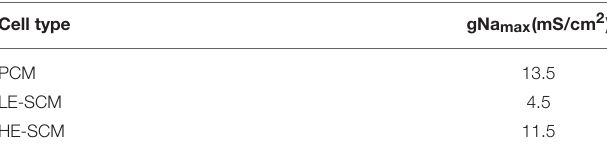
TABLE 1 | gNa max of PCMs and the two types of SCMs with LE and HE used in the computer model. Cell type